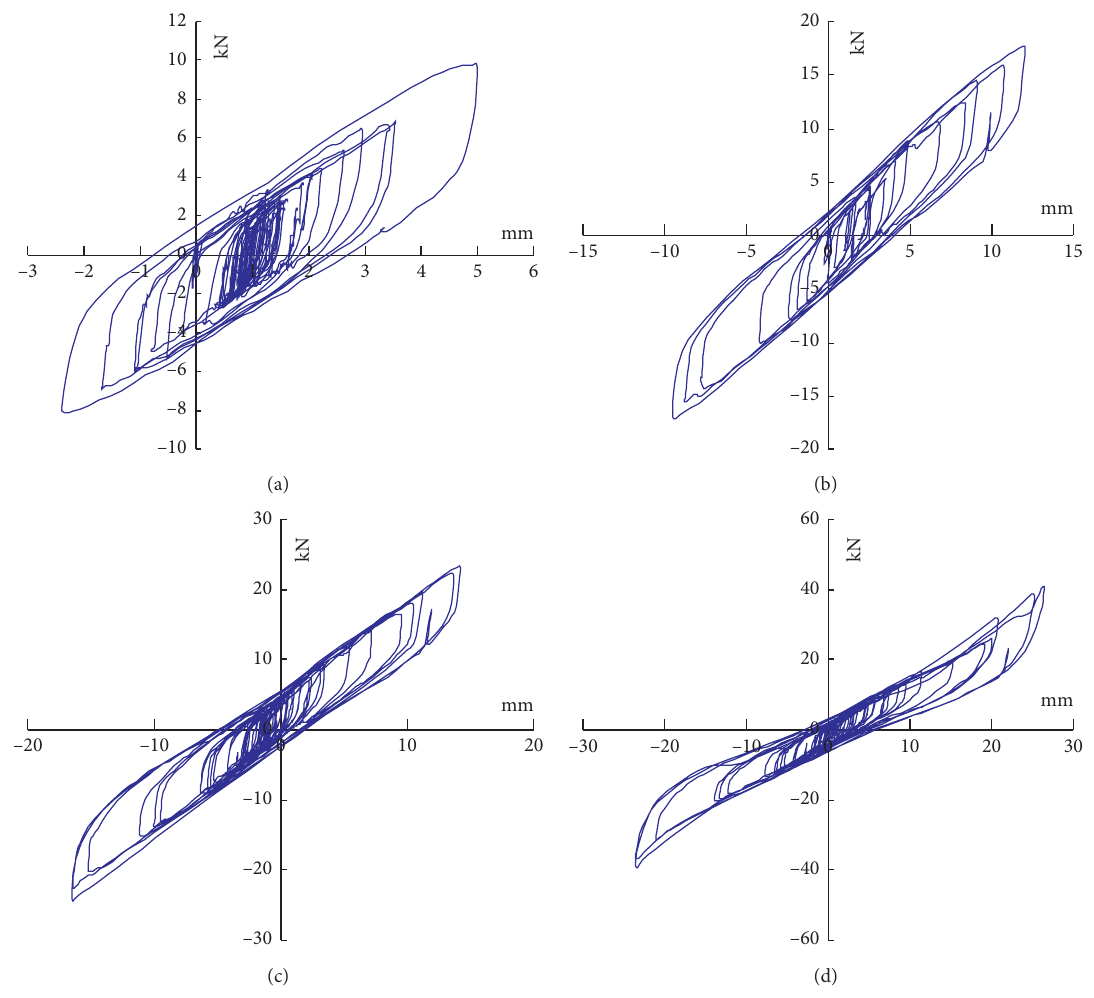
Figure 10: Specimens MLQT-3 hysteretic curve: (a) 100gal; (b) 280gal; (c) 400gal; (d) 620